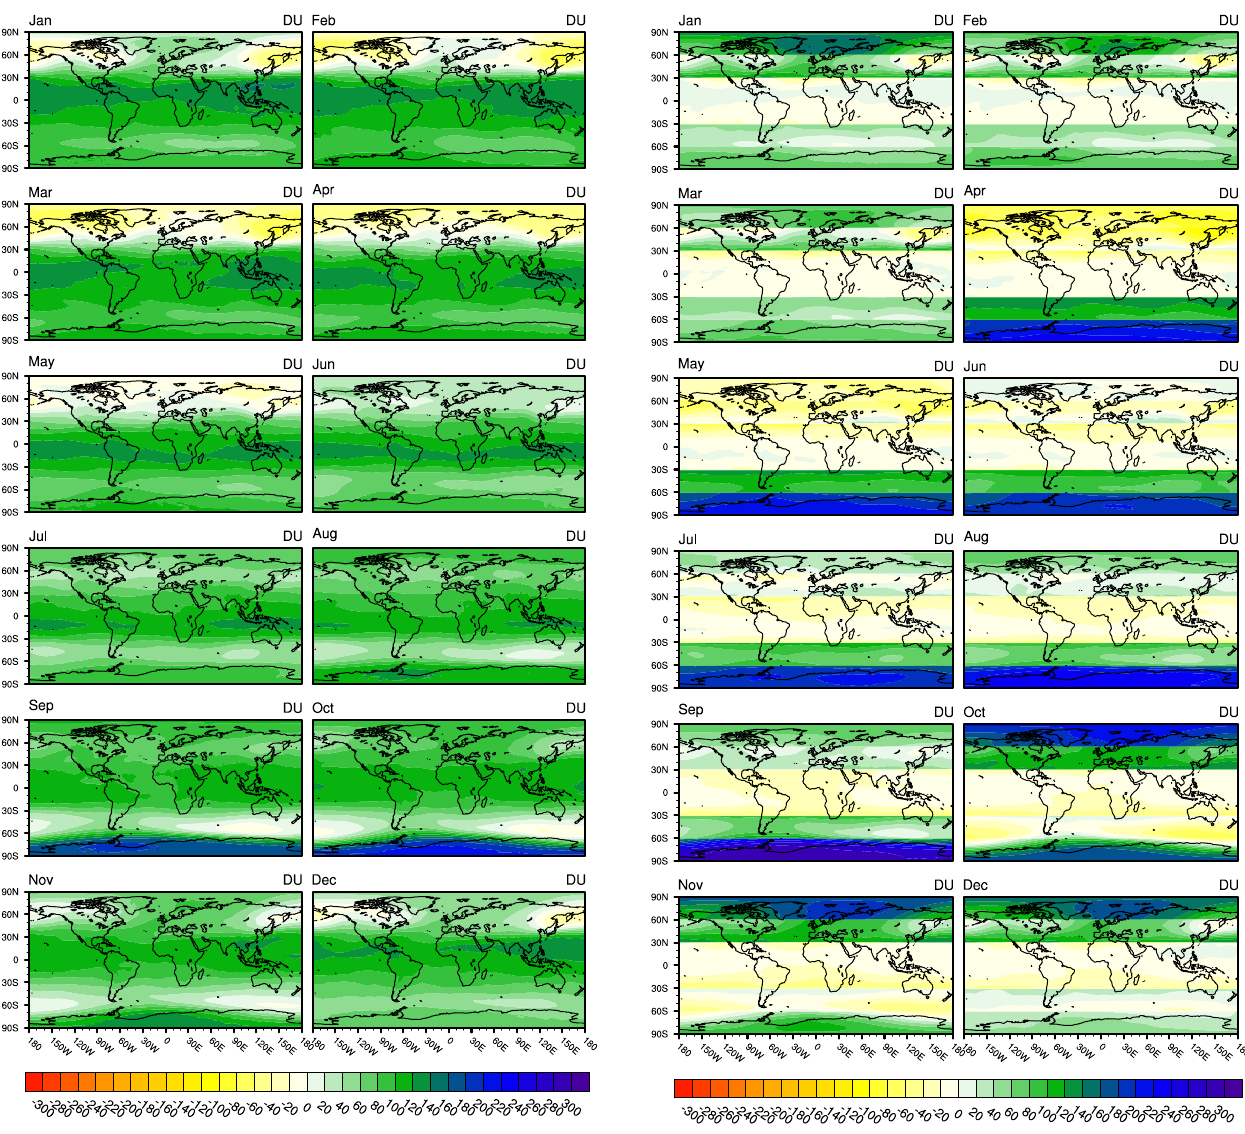
Figure 5. Bias in the total ozone column using the MSR monthly averages for the period (1979–2008) as a baseline for